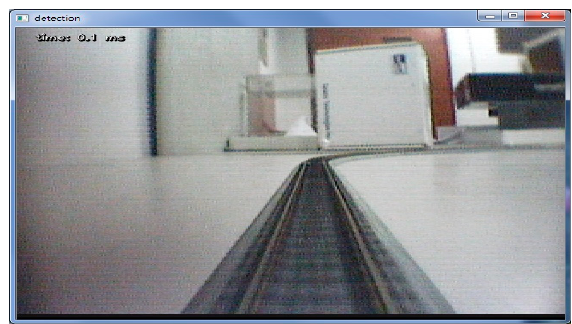
Figure 8. Images from the wireless CMOS camera.